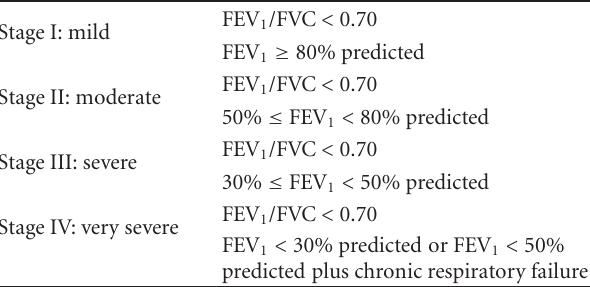
Table 1: Spirometric classification of COPD severity: gold staging